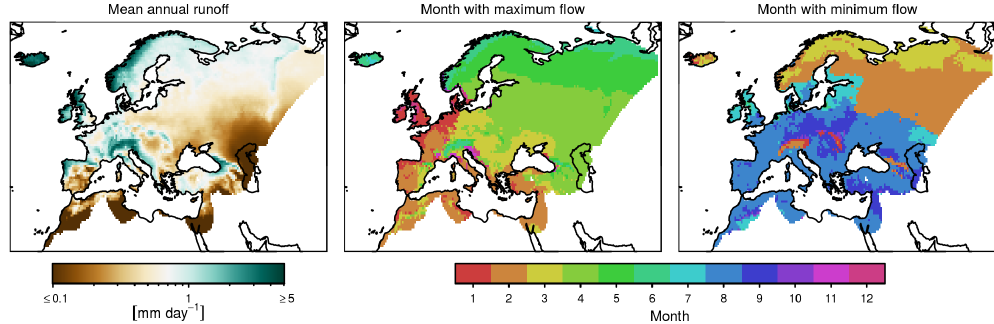
Figure 12. Long-term mean of the presented gridded runoff field as well as the month of the maximum and minimum of the mean annual cycle.